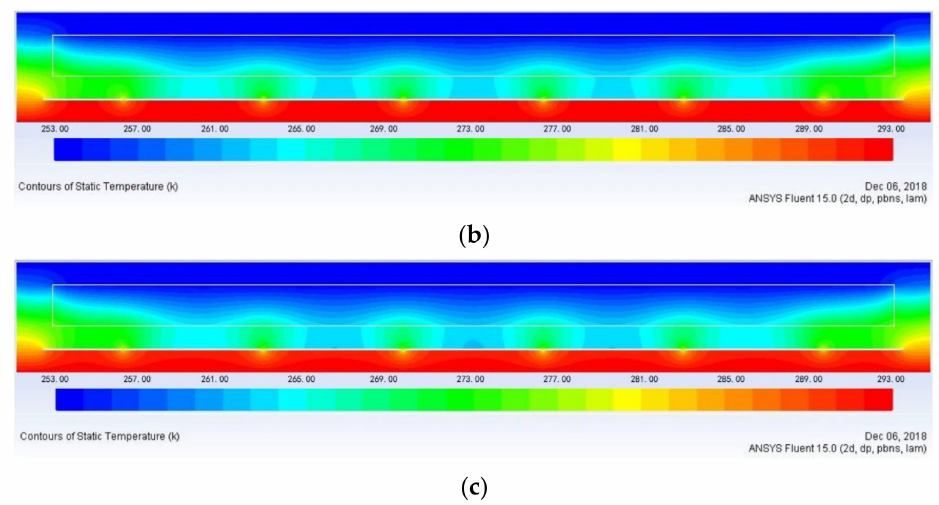
Figure 9. Temperature distribution cloud map of the CVG system with Low-E coatings located in different positions. Scenario ( a ) 1LC-I; ( b ) 1LC-V; ( c ) 2LC-V.